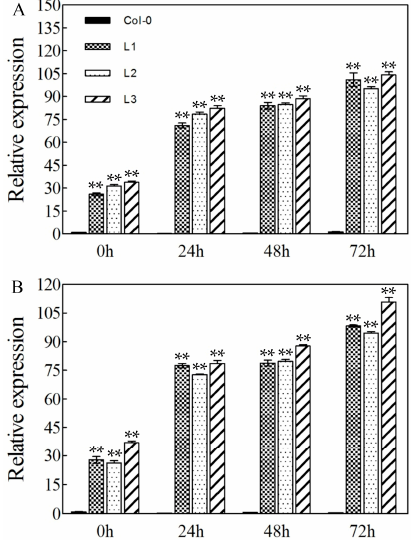
Figure 3. VaERF20 expression analysis in three transgenic A. thaliana lines and Col-0 following inoculation with different pathogens. Quantitative real-time PCR for VaERF20 expression patterns following Botrytis cinerea ( A ) and Pst DC3000 ( B ) inoculation. Data represent the means ± standard deviation from three independent experiments. Asterisks indicate statistical significance (** p < 0.01, one-way ANOVA) between n transgenic A. thaliana and Col-0 samples.